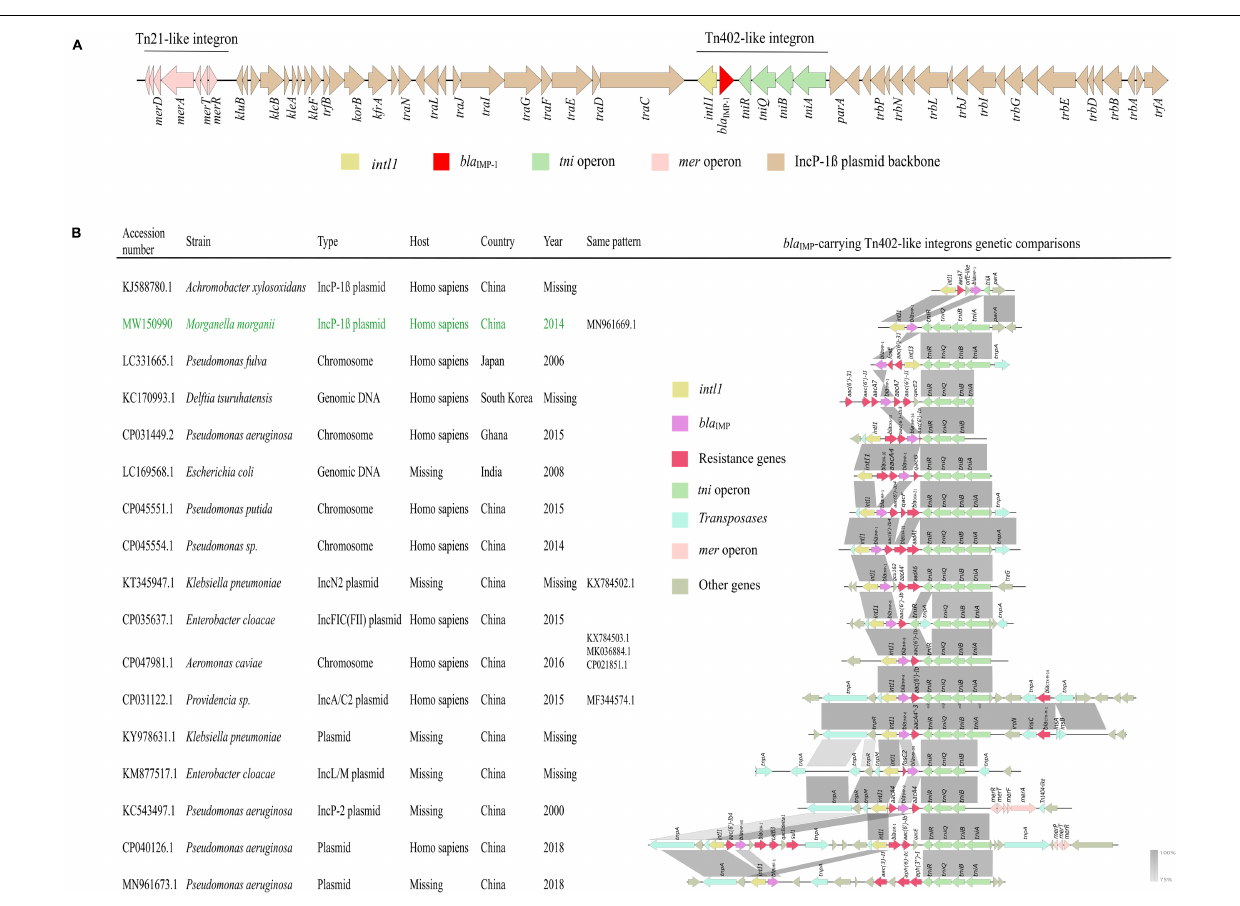
FIGURE 5 | (A) Genetic structure of pNXM63-IMP. The region of Tn 402 -like integron is indicated on the horizontal line. (B) Genetic context comparisons among bla IMP -carrying Tn 402 -like type 1 integrons. Other information, such as accession number, strain, sequence type, host, country, year and sequences with the same genetic pattern are also shown. The information of the Tn 402 -like type 1 integron found in pNXM63-IMP in this study is shown in green. Genes and ORFs are shown as arrows, which indicate their orientations of transcription. Shared regions with 75–100% identity are indicated by gradual shading. The picture was drawn with Easyfig